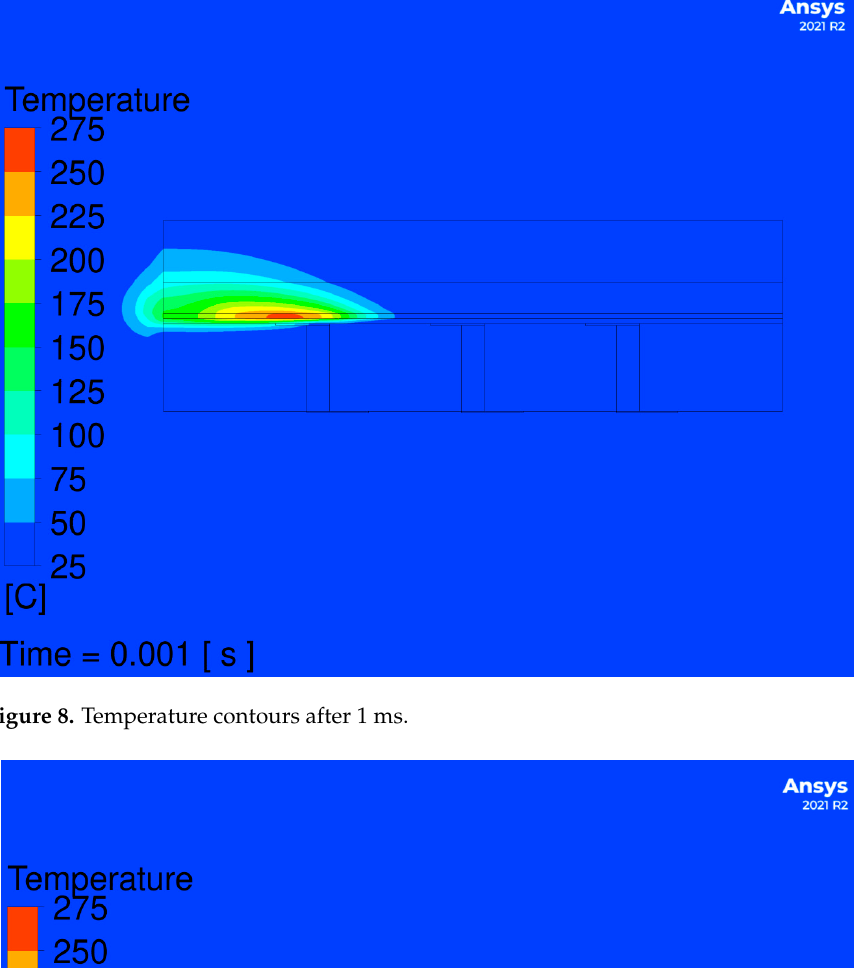
Figure 8. Temperature contours after 1 ms.